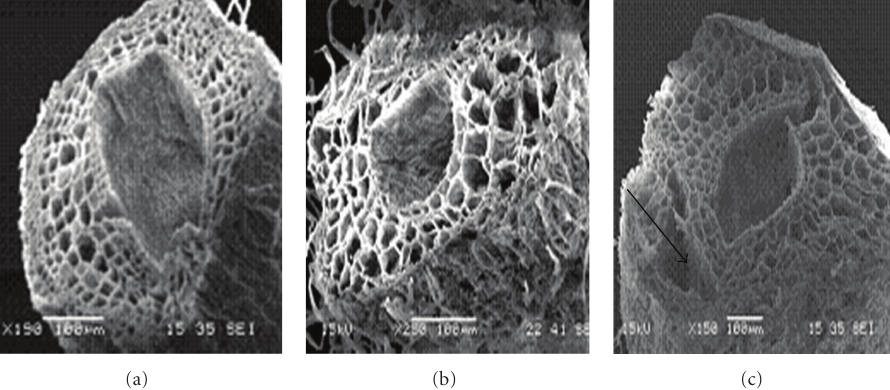
Figure 7: Scanning electron microscopy photographs showing root cortical tissue of C. dactylon “Satiri” under (a) 0, (b) 24, and (c) 48dSm − 1 . The arrow indicates cell damage (c) compared to control